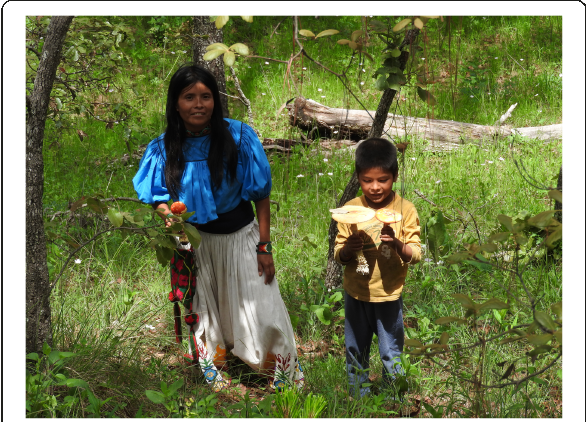
Fig. 2 Robertina Valdez, Wixarika woman teaching her son how